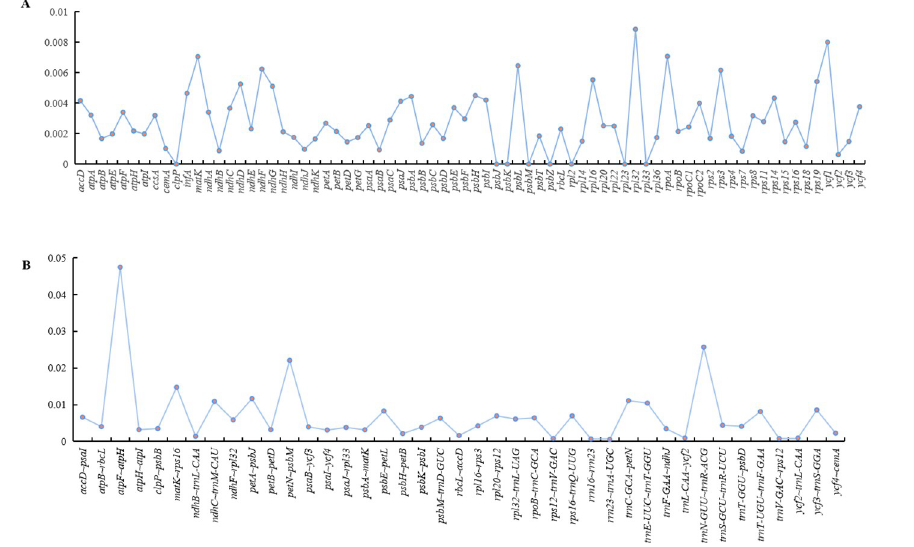
Fig 5. Nucleotide diversity (Pi) in the chloroplast genome of ten Myristicaceae species. (A:Pi value (range from 0–0.00886) of protein coding genes; B:Pi value (0.00054–0.04744) of intergenic regions genes).